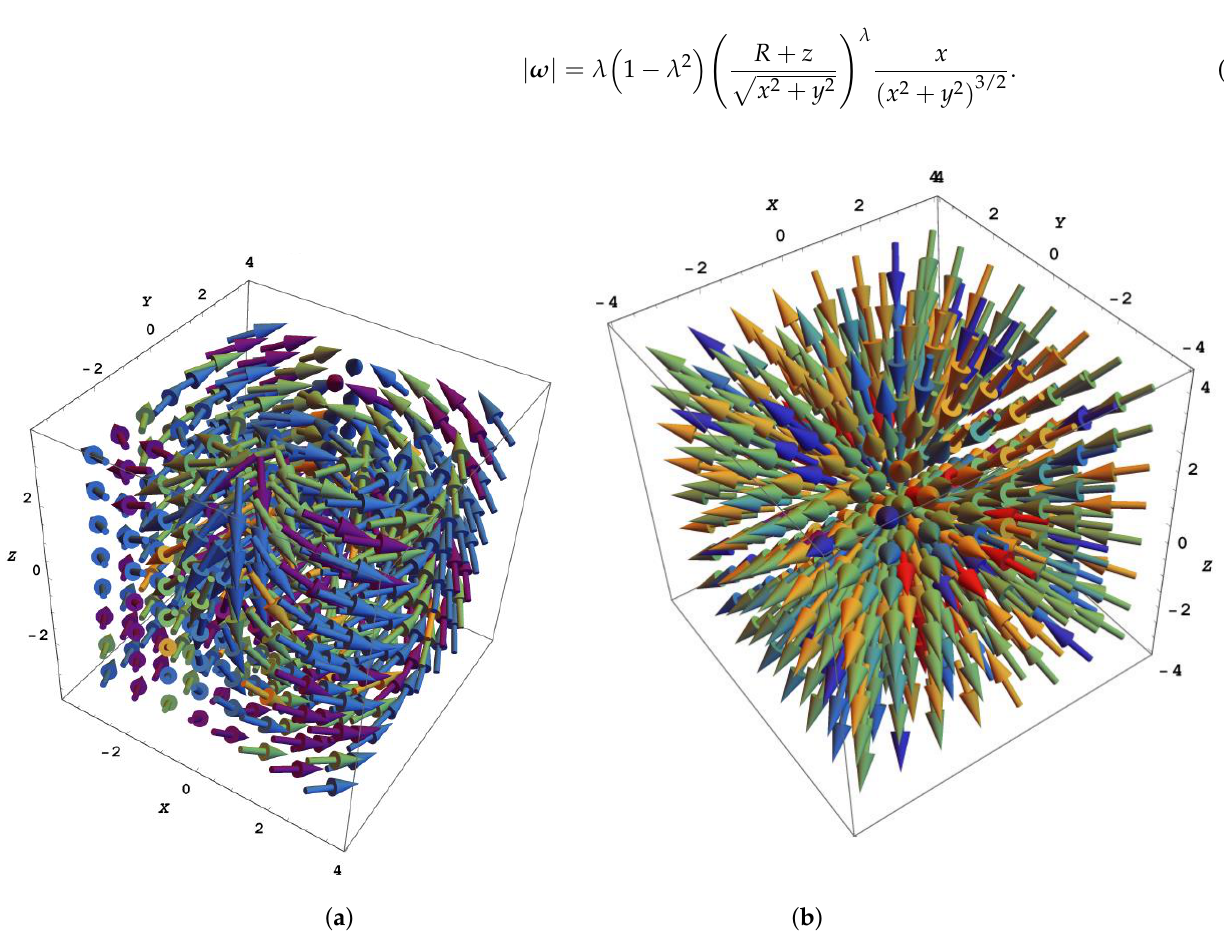
Figure 1. Fragments of ( a ) the velocity field as per Equation (22), and ( b ) the vorticity field as per Equation (23) for λ =